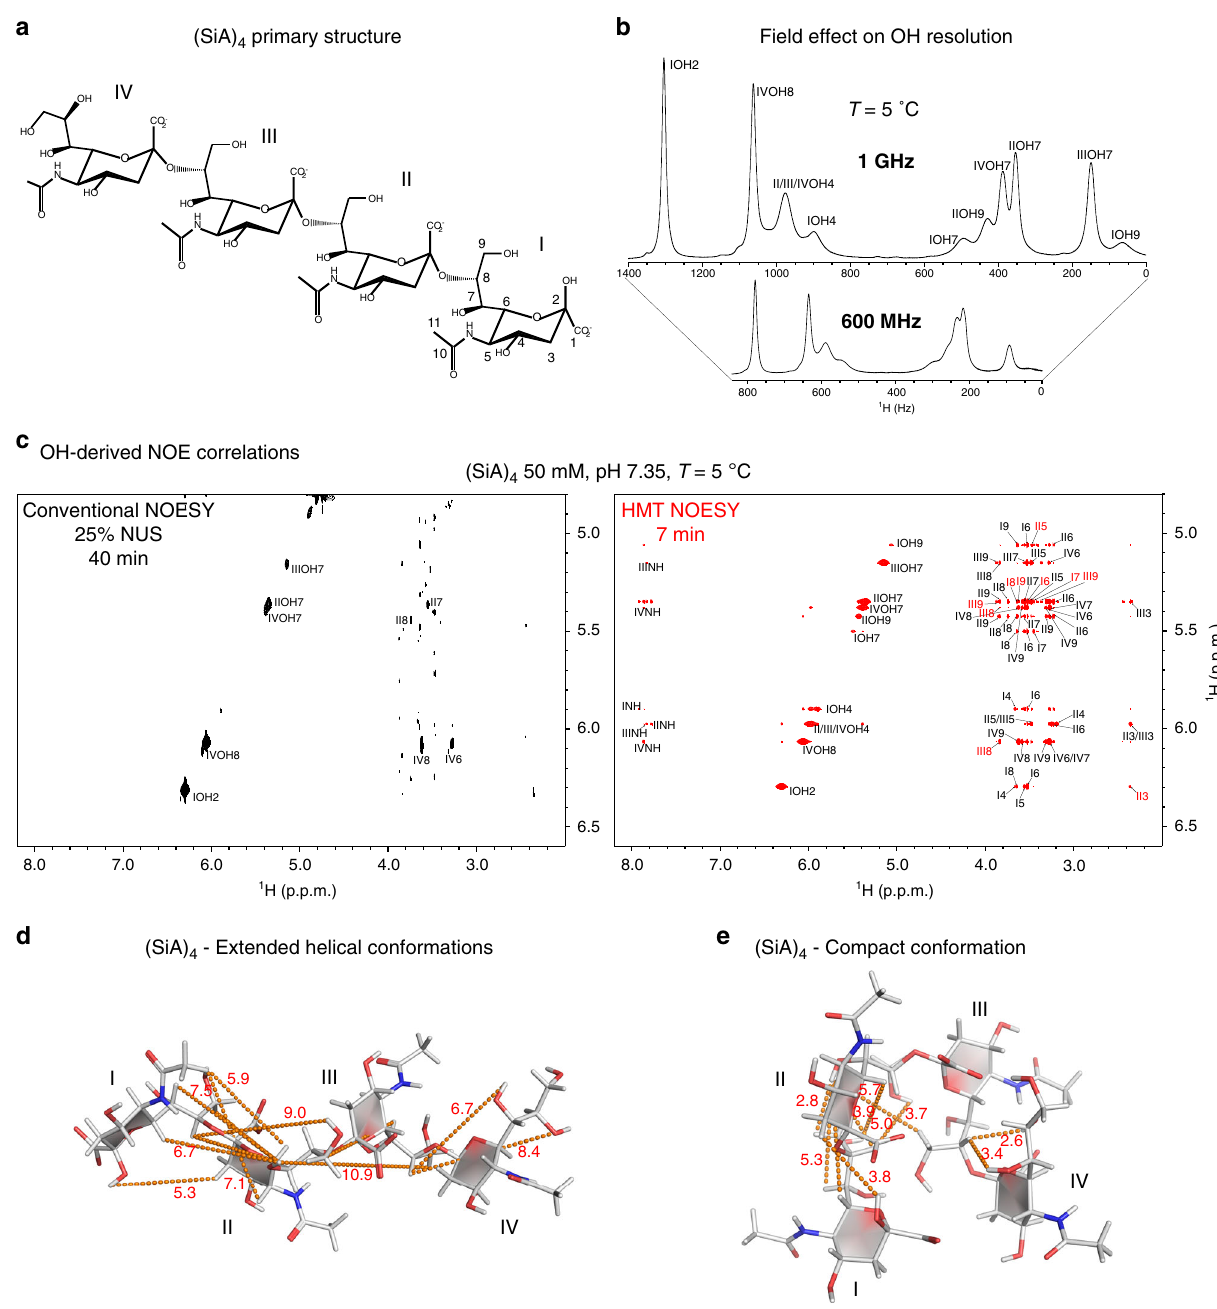
Fig. 2 HMT applied to the hydroxyl groups of an α 2,8-linked sialic acid tetramer. a Primary structure of (SiA) 4 , depicting the rings ’ numbering and the multiple hydroxyl and amide labile 1 Hs. b Magnetic fi eld effect on the appearance of (SiA) 4 ’ s hydroxyl 1 H spectrum. Note how the chemical exchange broadens certain hydroxyl resonances at 600MHz, whereas at 1GHz most of the peaks are well-resolved, thanks to fi eld-induced separation of the exchanging sites. c Comparison between a conventional 2D NOESY acquired using 25% non-uniform sampling for a minimal acquisition time with faithful spectral reconstruction, and Hadamard MT NOESY collected with a 600ms saturation period. Although conventional NOESY only reveals some of the closest neighbors, richer information (coupled to much shorter acquisitions) is provided by the HMT. These 1GHz spectra were acquired using a Bruker Avance Neo console equipped with a TCI cryoprobe; Table 1 summarizes some of the enhancements observed for this compound. d Con fl icts arising between the cross-relaxation peaks observed in the HMT NOESY spectrum (highlighted in c with red fonts and indicated here by dashed lines) and the extended structure proposed for this homopolymer at − 10°C based on non-labile 1 H NOEs 47 . Notice the long distances (in Å) indicated by the dashed lines for some of the new NOESY-derived experimental connectivities. e Revised, compact structure, compatible with the labile 1 H ’ s NOEs, showing substantial distance